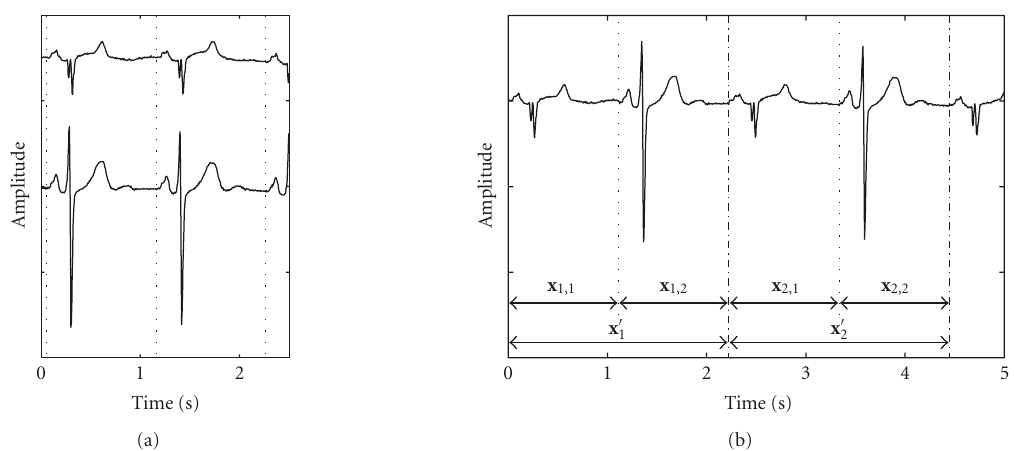
Figure 3: Concatenation of a two-lead ECG signal containing two beats. (a) Each beat of the two leads is piled up into (b) one single vector.